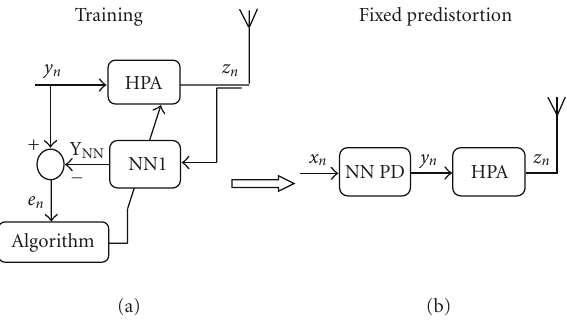
Figure 10: Block diagram for training of the PD with